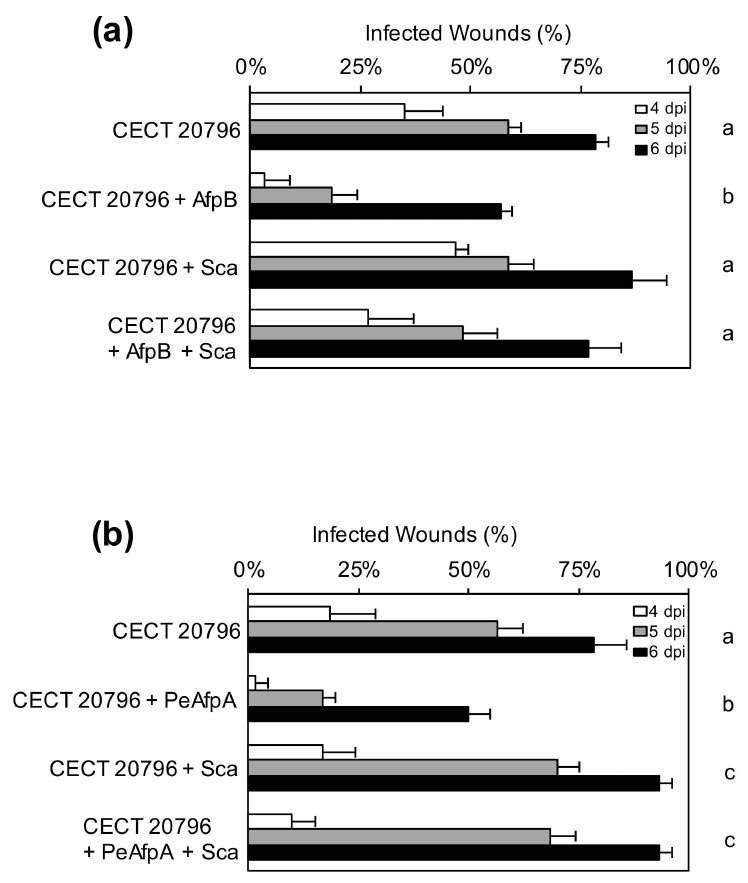
Figure 6. Effect of different proteins and protein combinations on the infection caused by P. digitatum CECT 20796 strain. ( a ) Incidence of infection of wounds inoculated with 10 4 conidia / mL of parental CECT 20796 strain alone or in the presence of 100 µ g / mL of AfpB, 180 µ g / mL of Sca or combinations of both proteins. Data indicate the percentage of infected wounds (mean values ± SD of three replicates of five oranges) at each dpi. Different letters show statistical significance of the infection incidence compared to the control sample at 6 days (ANOVA and Tukey’s HSD, p < 0.05). ( b ) Incidence of infection of wounds inoculated with 10 4 conidia / mL of parental CECT 20796 strain alone or in the presence of 100 µ g / mL of PeAfpA, 180 µ g / mL of Sca or combinations of both proteins. Other details as in ( a